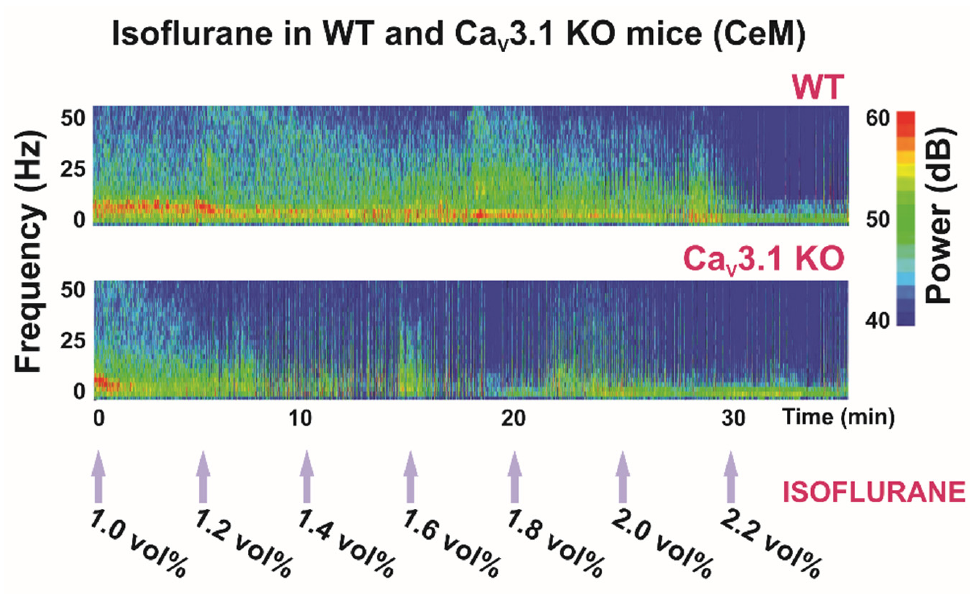
Figure 2. Thalamic (central medial nucleus of thalamus—CeM) heat maps of local field potentials (LFPs) under isoflurane in WT and Ca V 3.1 KO animals.